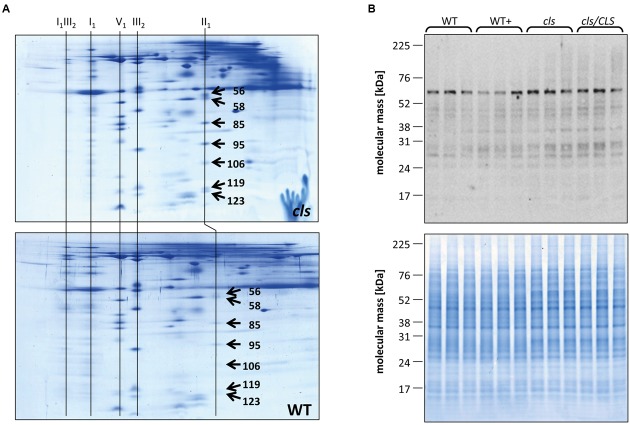
Quantitation of II1 subunits.
(A) Representative Coomassie stained BN/SDS gels of cls and WT mitochondria. Spots on gel images were matched and spots volumes were calculated using a commercially available gel analysis tool. The numbers on the spots represent the spot IDs given to the spots by the software. Identities of protein complexes are indicated on top of the gels. (B) Immunoblot against the flavoprotein subunit (SDH1-1, AT5g66760, 69.7 KDa) of II1 in mutant and WT lines grown in the presence/abscence of estradiol (upper panel). A Coomassie stained gel of cell extracts of the four lines is shown as loading control (lower panel).